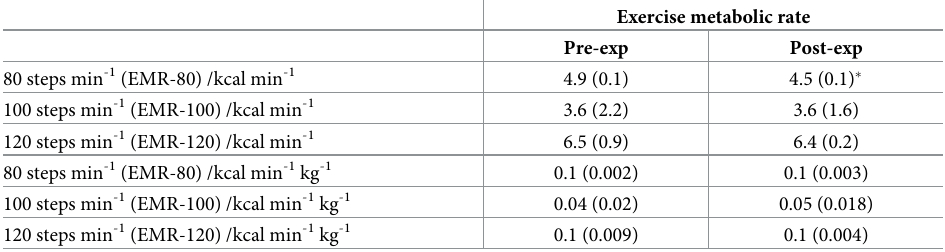
Table 5. Average [median (IQR)] energy expenditure during exercising (EMR) pre- and post-expedition for the three exercise intensities.